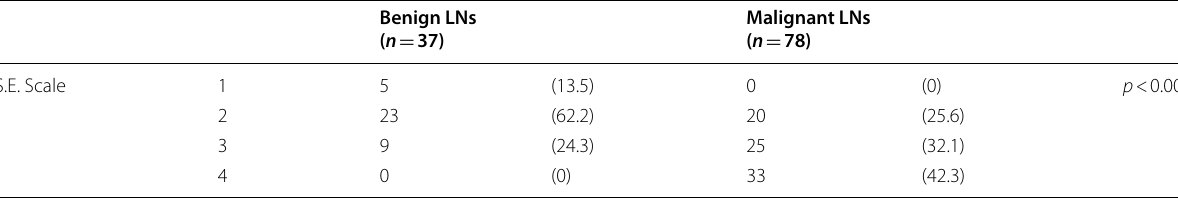
p : p value for comparing between benign and malignant * Statistically significant at p